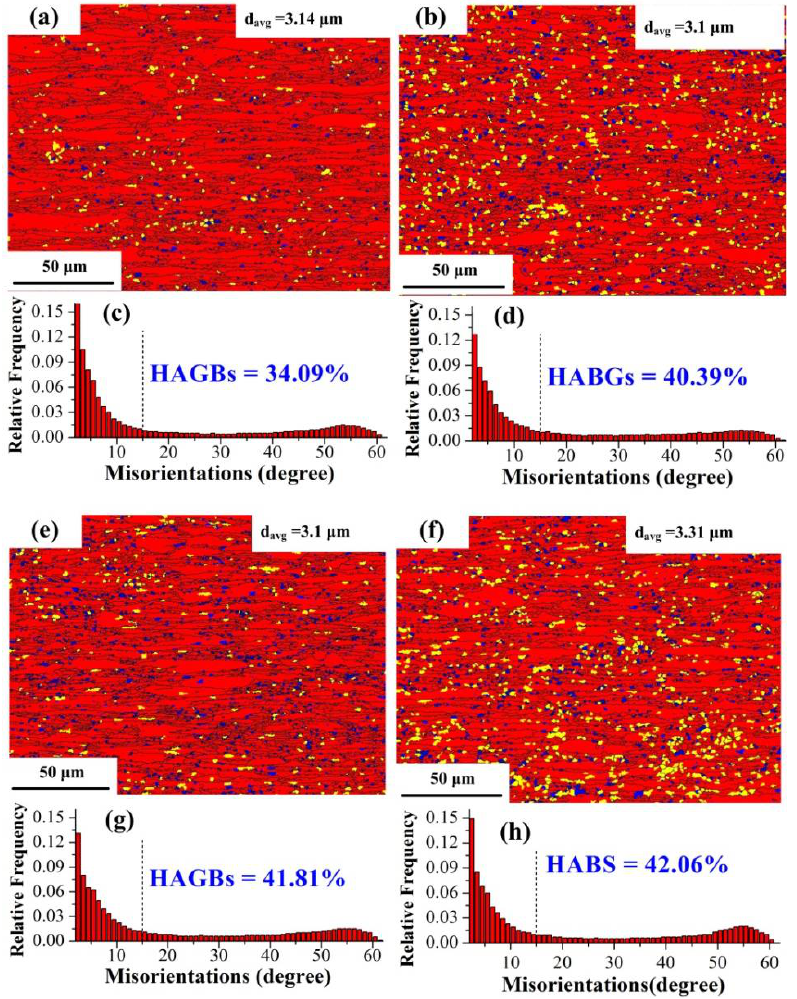
Figure 5. EBSD maps of recrystallized, substructure, and deformed grains; misorientation angle distributions ( a , c ) 600 °C , 0.01 s −1 ( b , d ) 650 °C, 0.1 s −1 ( e , g ) 700 °C, 0.1 s −1 ( f , h ) 700 °C, 1 s −1 .